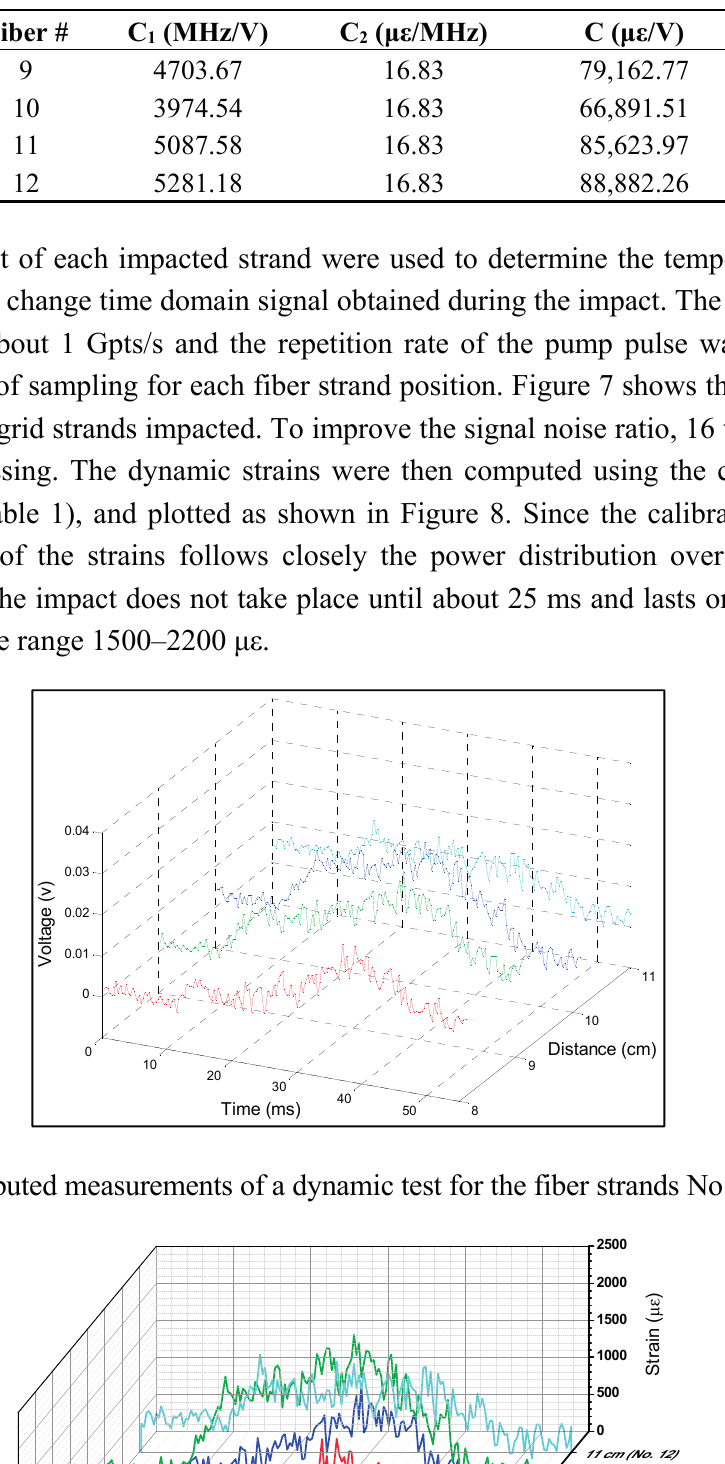
Table 1. Relationship between amplitude and strain.